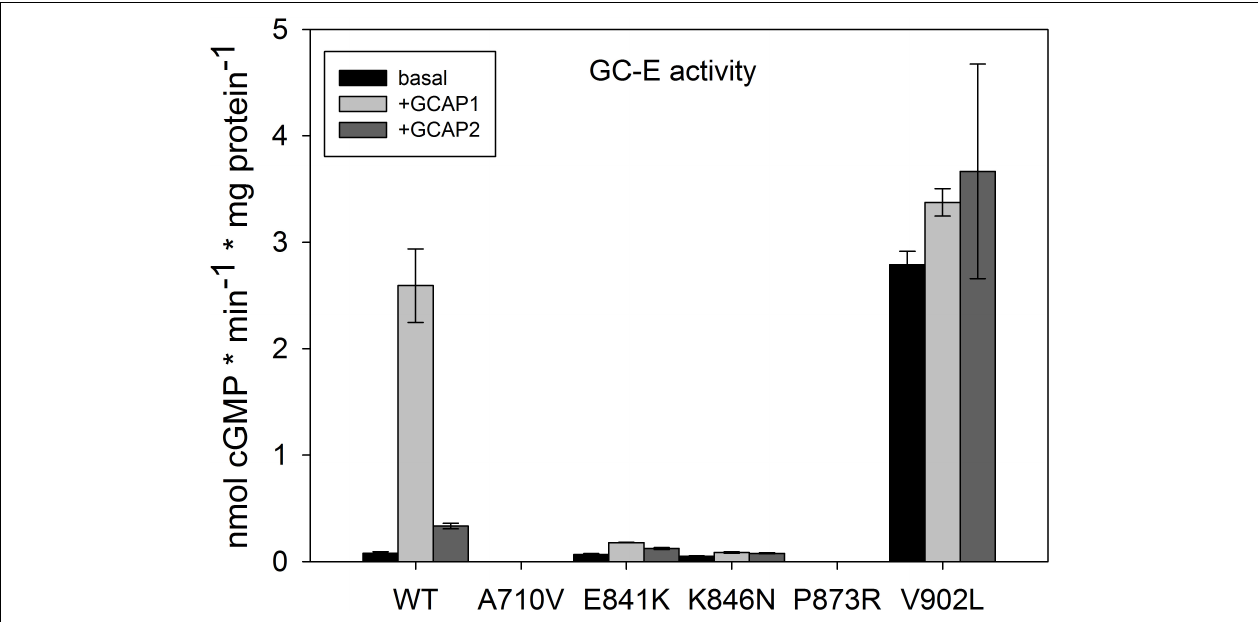
FIGURE 2 | Basal and GCAP-mediated activity of GC-E wildtype and mutants. Maximal activity of GC-E wildtype and mutants was measured via a GC-activity assay. The amount of produced cGMP per minute and µ g protein was calculated and compared between the wildtype and mutants. GC-E activation by GCAPs (5 µ M) was detected at low [Ca 2 + ] (1.7 nM). Each data point represents the mean value of three replicates with the standard deviation. The experiment was repeated twice with similar